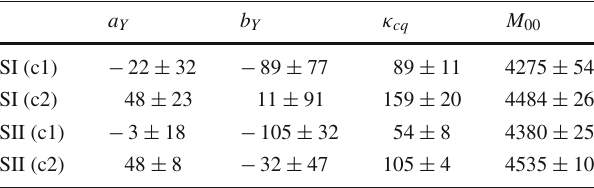
Table 3 Values of the parameters in scenarios I (SI) and II (SII) and ± 1 σ errors (all in MeV). Here, c 1 and c 2 refer to the two solutions